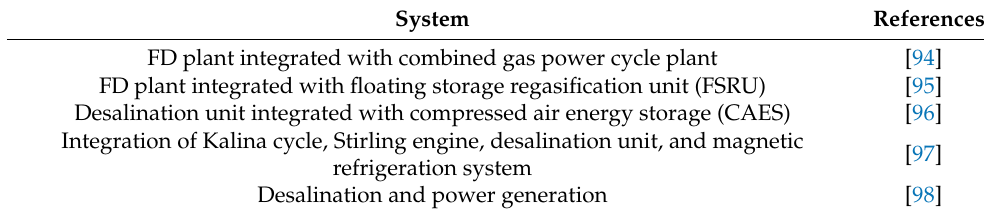
Table 4. Other works on desalination system using cold energy from LNG